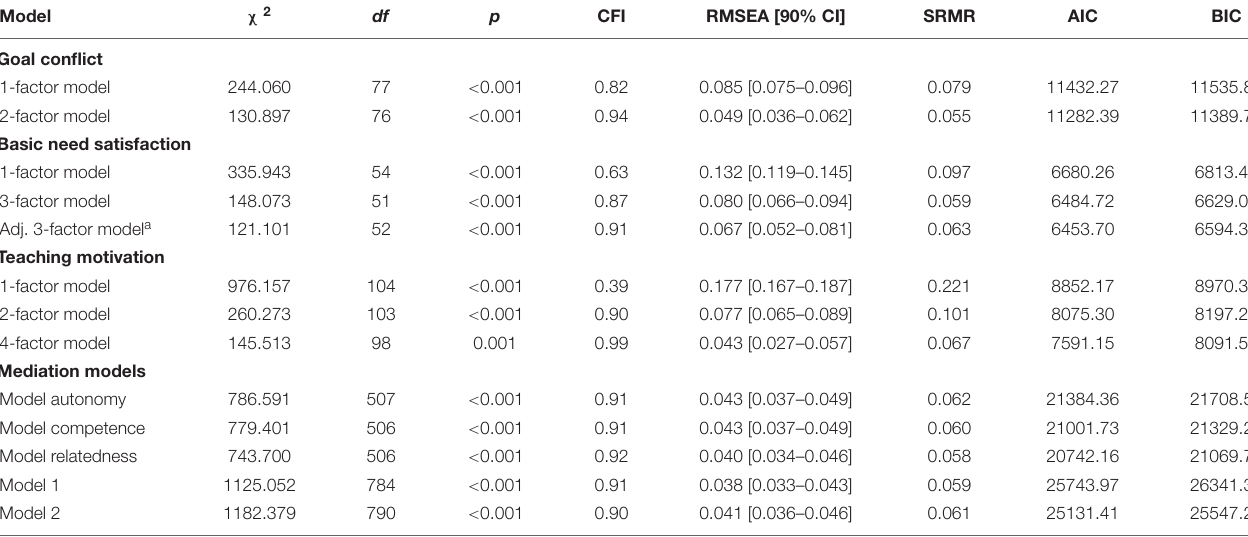
TABLE 2 | Model fit for measurement